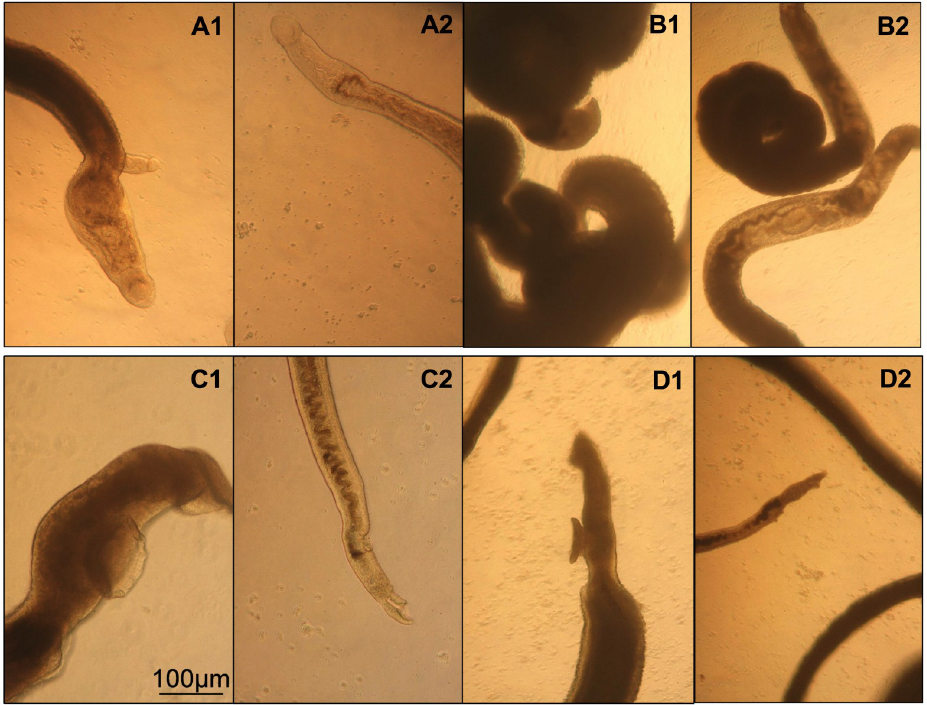
Fig 8. Screening of adult Schistosoma mansoni worms. Worms were treated at 30 μ M for 24 hours with A: DMSO (0.3% v/v), A1: Paired male and female worm (5x), A2: Female worm (10x); B: Praziquantel, B1: Male worm (5x), B2: Female worm (5x); C: Perhexiline, C1: Male worm (10x), C2: Female worm (10x); D: Astemizole, D1: Male worm (5x), D2: Female worm (5x). DMSO: Dimethyl sulfoxide, x: magnification; v/v: volume by volume.